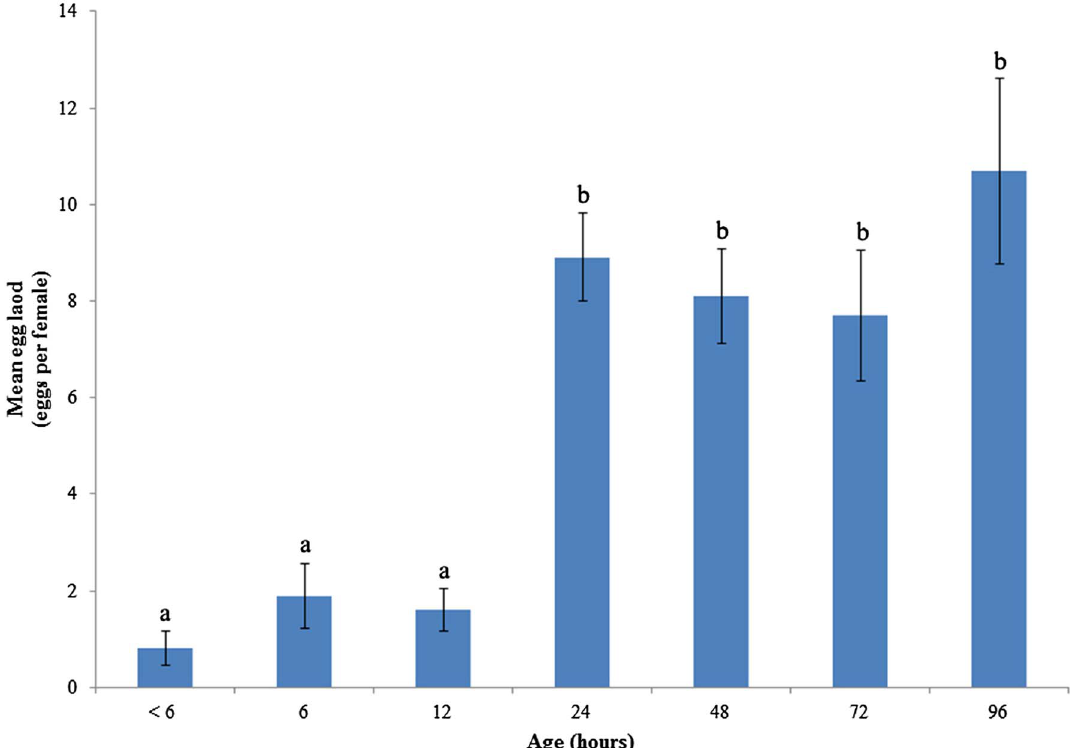
Figure 3. Effect of age on mean egg load of Quadrastichus mendeli ( F = 14.48; df = 6; p < 0.01). Vertical bars indicate standard error.